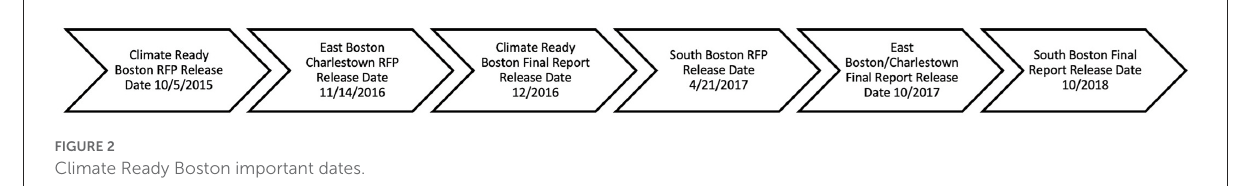
FIGURE2 Climate Ready Boston important